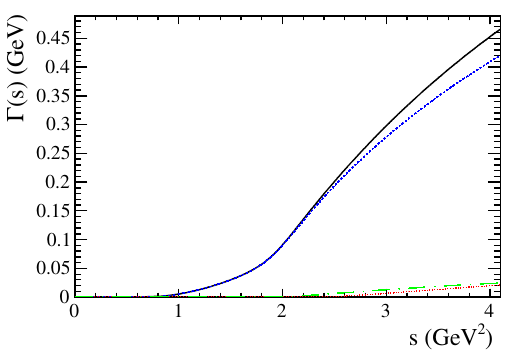
Figure 16 . Energy-dependent width for the (cid:25) 2 (1670) resonance. The total width is shown in black (solid), while the partial widths into the channels (cid:25)(cid:25)(cid:25) , !(cid:26) (770) and K (cid:22) K(cid:25) are shown in blue (dashed), red (dotted) and green (dashed-dotted), respectively.